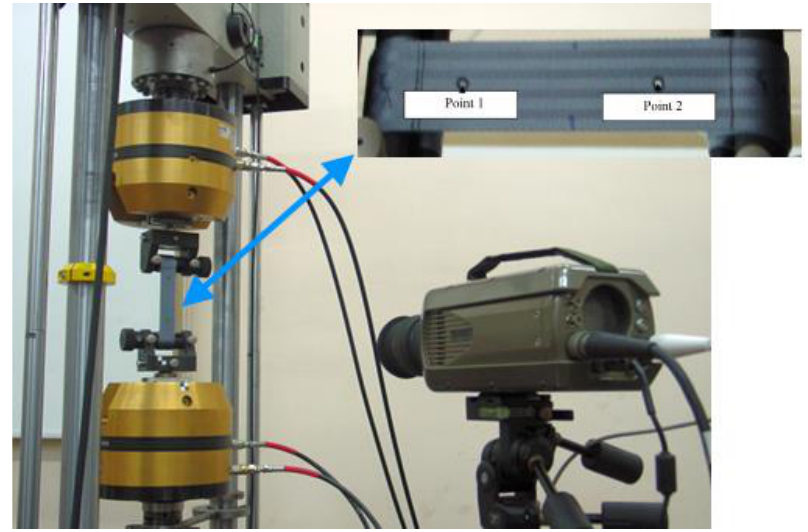
Figure 3. Stress vs. volumetric strain curves for seat foams, based on [21] (with permission of Editor in Chief of Acta of Bioengineering and Biomechanics).